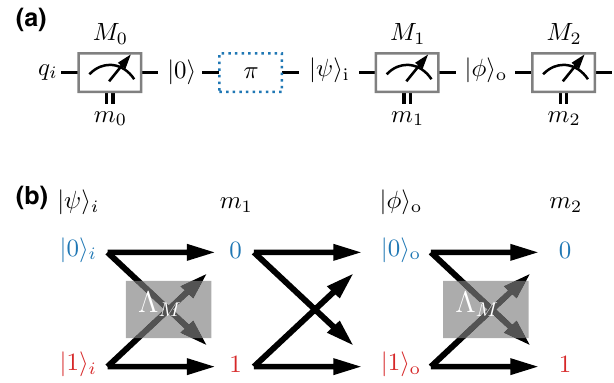
FIG. 13. The butterfly measurement scheme for readout characterization. (a) Circuit diagram for the butterfly experi- ment to characterize measurement M 1 on qubit q i . Postselection based on an initial measurement M 0 is used to initialize | 0 (cid:8) . (b) are described by (cid:13) M . Correlations between m 1 and | ψ (cid:8) i (respectively, | 1 (cid:8) ). The fidelity and the QND-ness of a o realistic measurement are defined